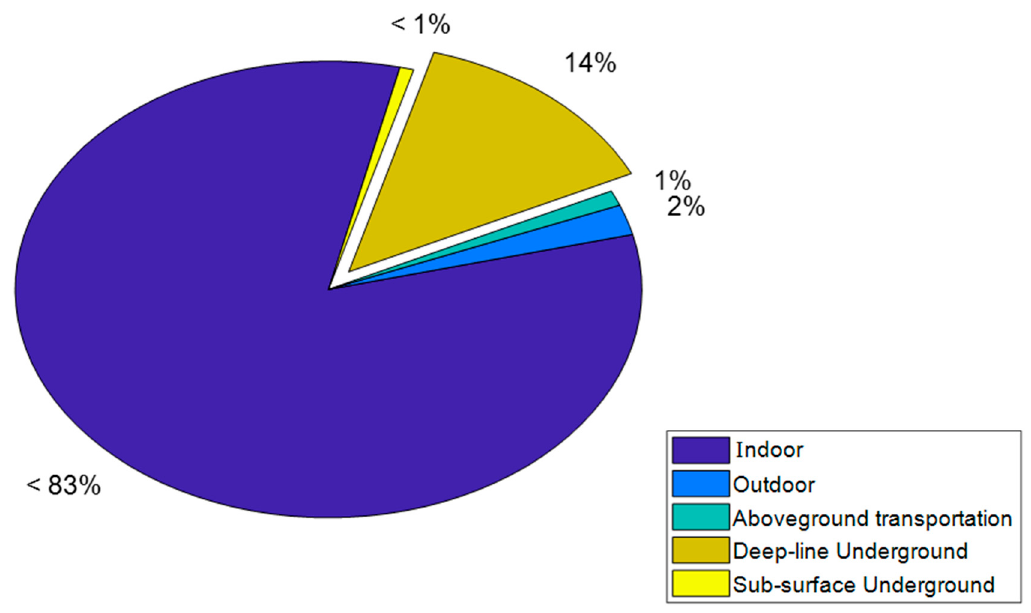
Figure 4. Contribution of each microenvironment (ME) to the total exposure. Indoor exposure shows the greater contribution followed by the deep underground lines.